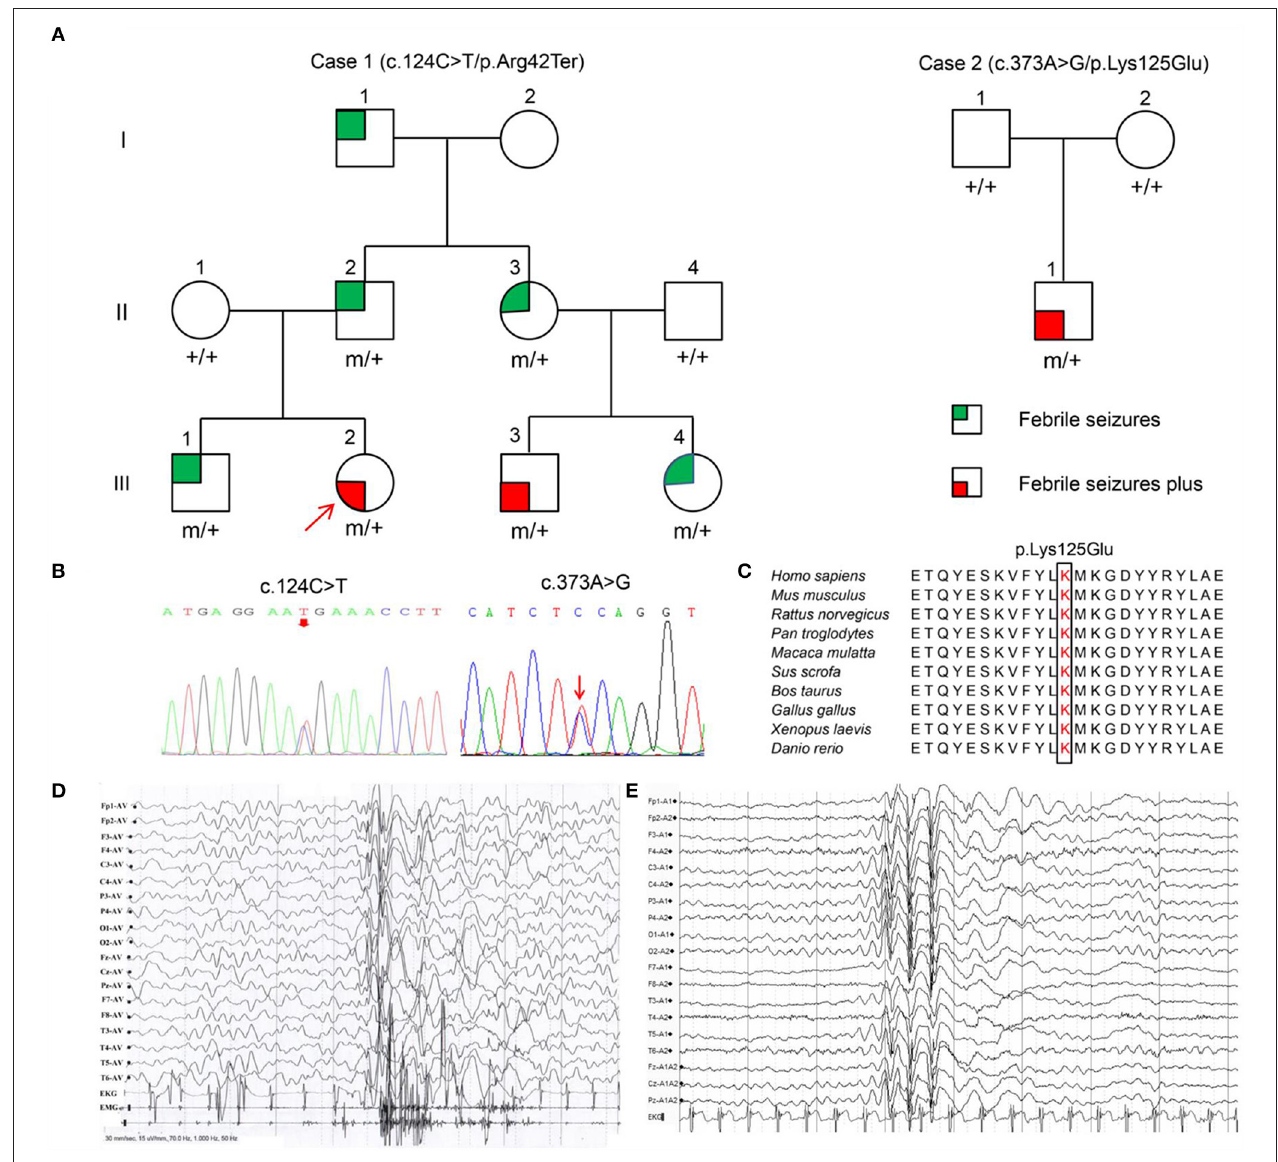
FIGURE 1 | Pedigrees, YWHAG mutations and EEG changes in the proband. (A) Pedigrees of the families with YWHAG mutations. Individuals with mutation are indicated by m/ + , and those negative for mutation are indicated by + / + . (B) Sequencing chromatograms of c.124C > T and c.373A > G. (C) The amino acid sequence alignment of 14-3-3 γ showed that the residue Lys125 was highly conserved in various species. (D) Ictal EEG changes in the proband with mutation Arg42Ter showed myoclonic seizures with generalized irregular polyspike-and-slow waves (obtained at the age of 1 year). (E) Interictal EEG changes in the proband with mutation Lys125Glu showed generalized spike-and-slow waves (obtained at the age of 2